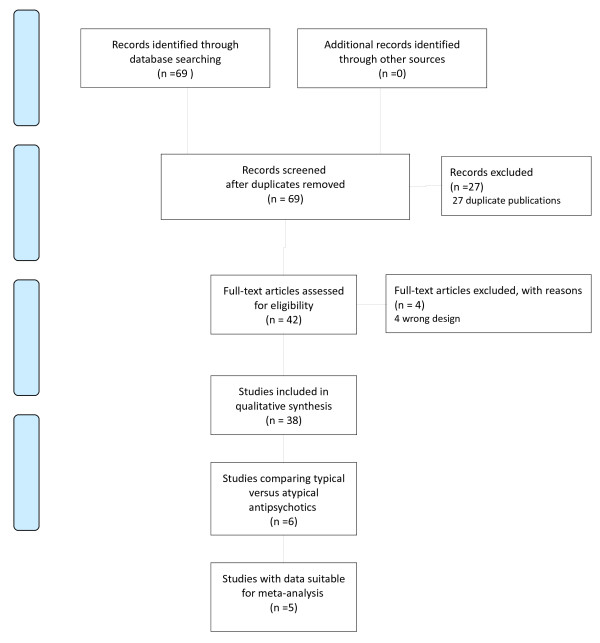
PRISMA Flow diagram.